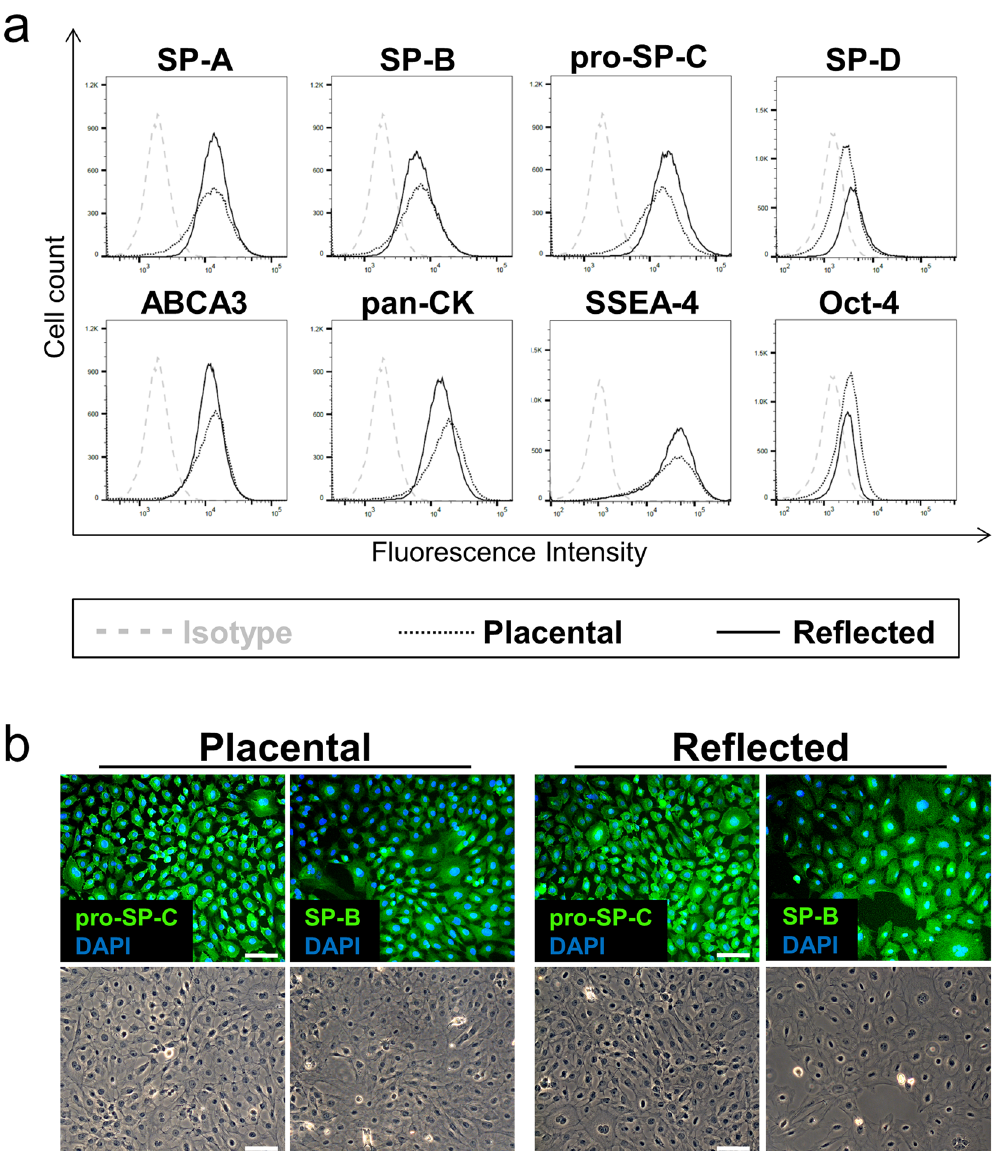
Figure 3. Expression of PS-associated proteins in isolated hAE cells. ( a ) Flow cytometric analysis of surfactant- associated proteins and stem cell markers immediately after hAE cells isolation. Cells show similar expression between both amniotic subregions, whereas in general hAE cells of the reflected region show moderately higher PS-associated protein expression and the placental area higher Oct-4 staining. n = 3–5. ( b ) Immunofluorescence staining of pro-SP-C and SP-B. The predominant part of hAM-derived epithelial cells exhibit distinct staining of both surfactant proteins in the cytoplasm, comparable in both amniotic subregions. Scale bars: 50 µ m. n =